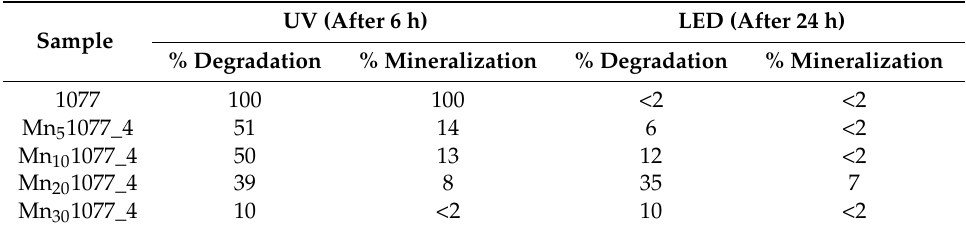
Table 1. Gaseous ethanol photodegradation and mineralization degrees by both pure and Mn-doped 1077 samples, under ultraviolet (UV) (after 6 h) and Light Emitting Diode (LED) (after 24 h) irradiation